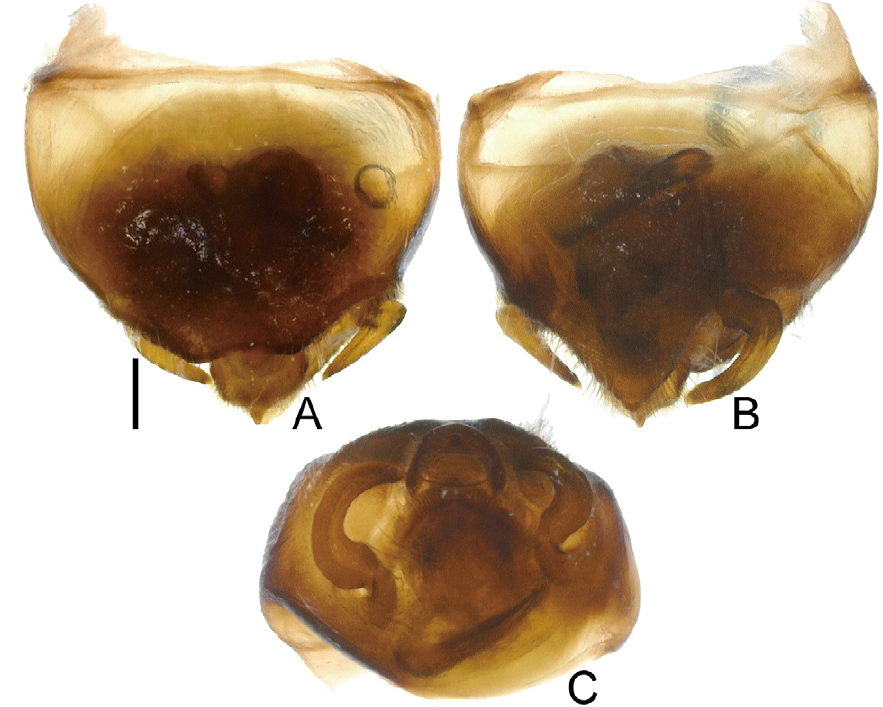
Figure 2. Pygophore of Alloeorhynchus reinhardi . A. Dorsal view. B. Ventral view. C. Posterior view. Scale bar: 0.2